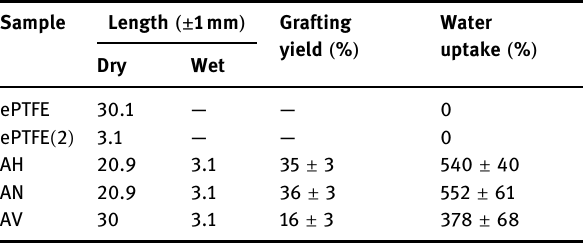
Table 1: Length, grafting yield, and water uptake of unmodi fi ed and modi fi ed ePTFE Sample